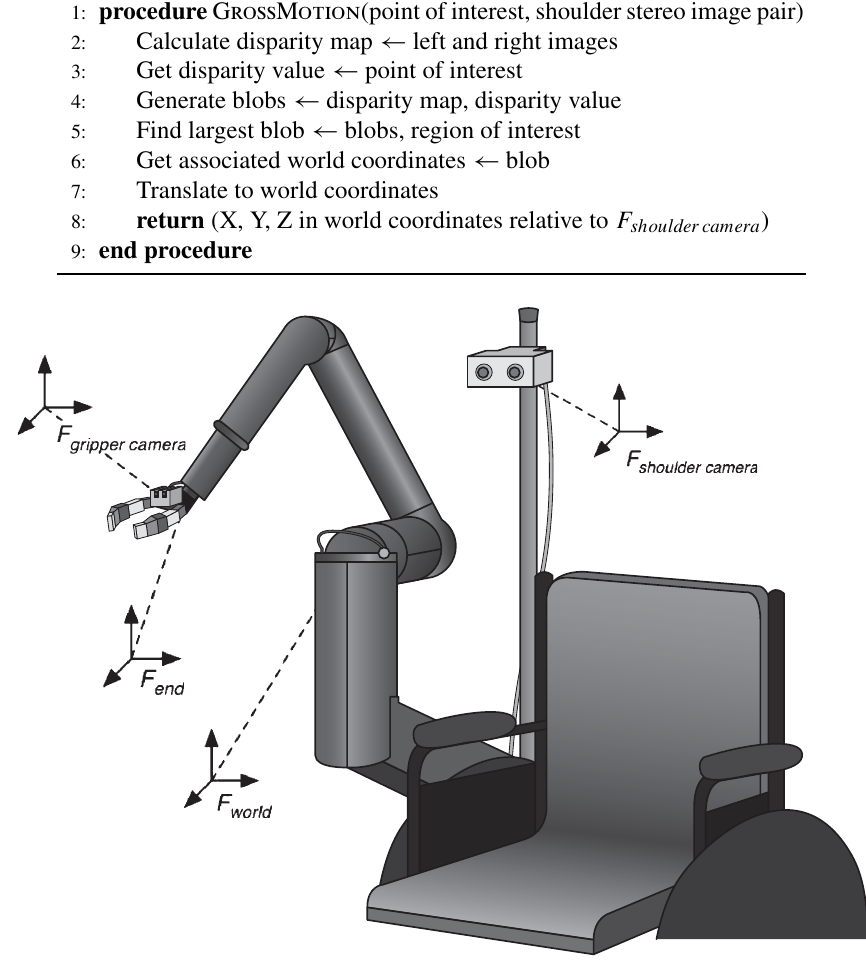
Fig. 4. Four coordinate frames are used to direct the Manus ARM’s end effector to retrieve an object. The center of our coordinate system is located at the top of the robot’s shoulder in the center ( F world